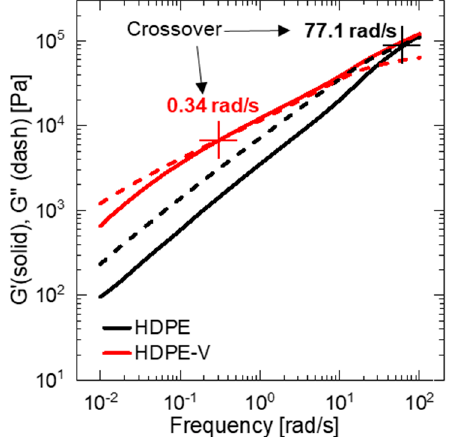
Figure 6. Dynamic moduli as a function of frequency for HDPE (black lines) and HDPE-V (red lines) at 220 °C. Storage modulus (G ′ ) is represented by the solid lines and viscous modulus (G ″ ) is represented by the dashed lines.